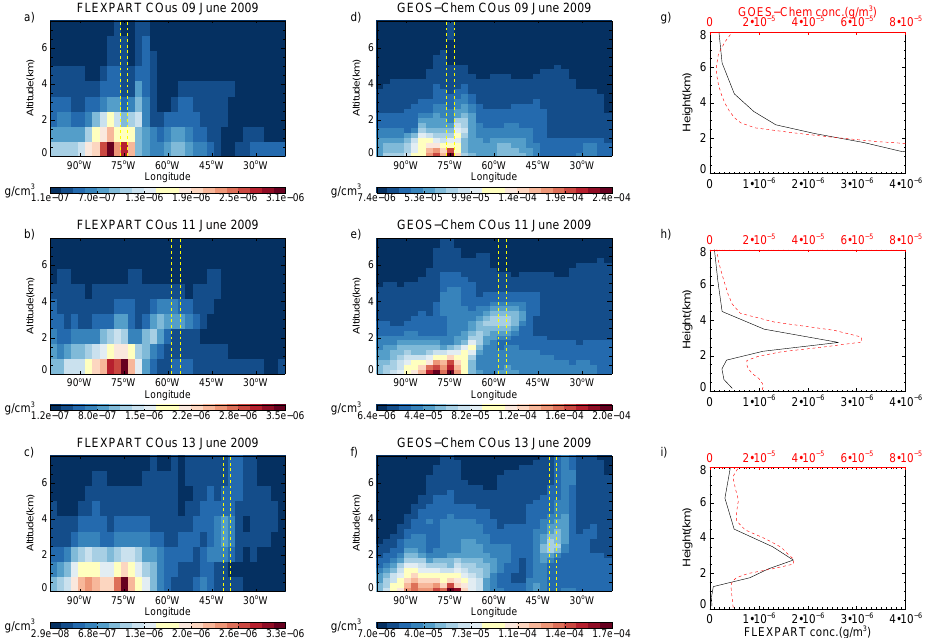
Fig. 4. Tagged North American CO simulation results for FLEXPART and GEOS-Chem at three upwind times for event 2: 9 June 2009, 18:00UTC (upper panel); 11 June 2009, 18:00UTC (middle panel); and 13 June 2009, 18:00UTC (lower panel). Concentrations of CO in panels (a–c) for FLEXPART and (d–f) for GEOS-Chem are averaged along the latitudinal region defined by the model domain (see the text). Panels (g–i) present tagged CO profiles from FLEXPART (solid black line) and GEOS-Chem (dashed red line) at the three upwind times with locations determined by maximum CO in folded results (UFQs). The plume locations are also marked with two dashed vertical lines in panels (a–f)